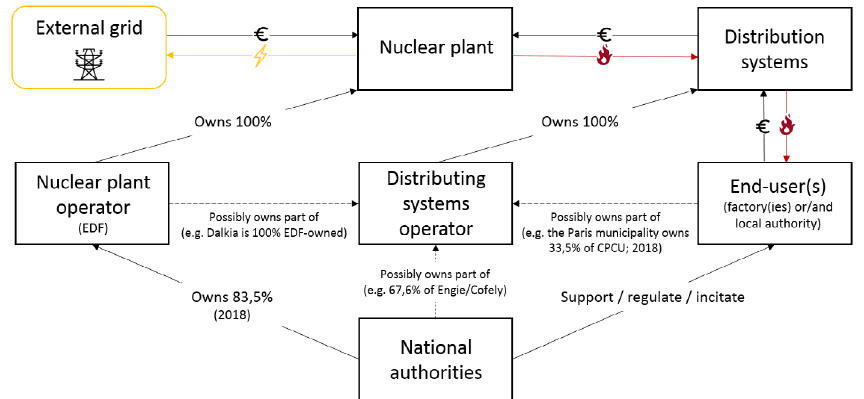
Figure 2. Organisation chart of a non-integrated energy cluster.